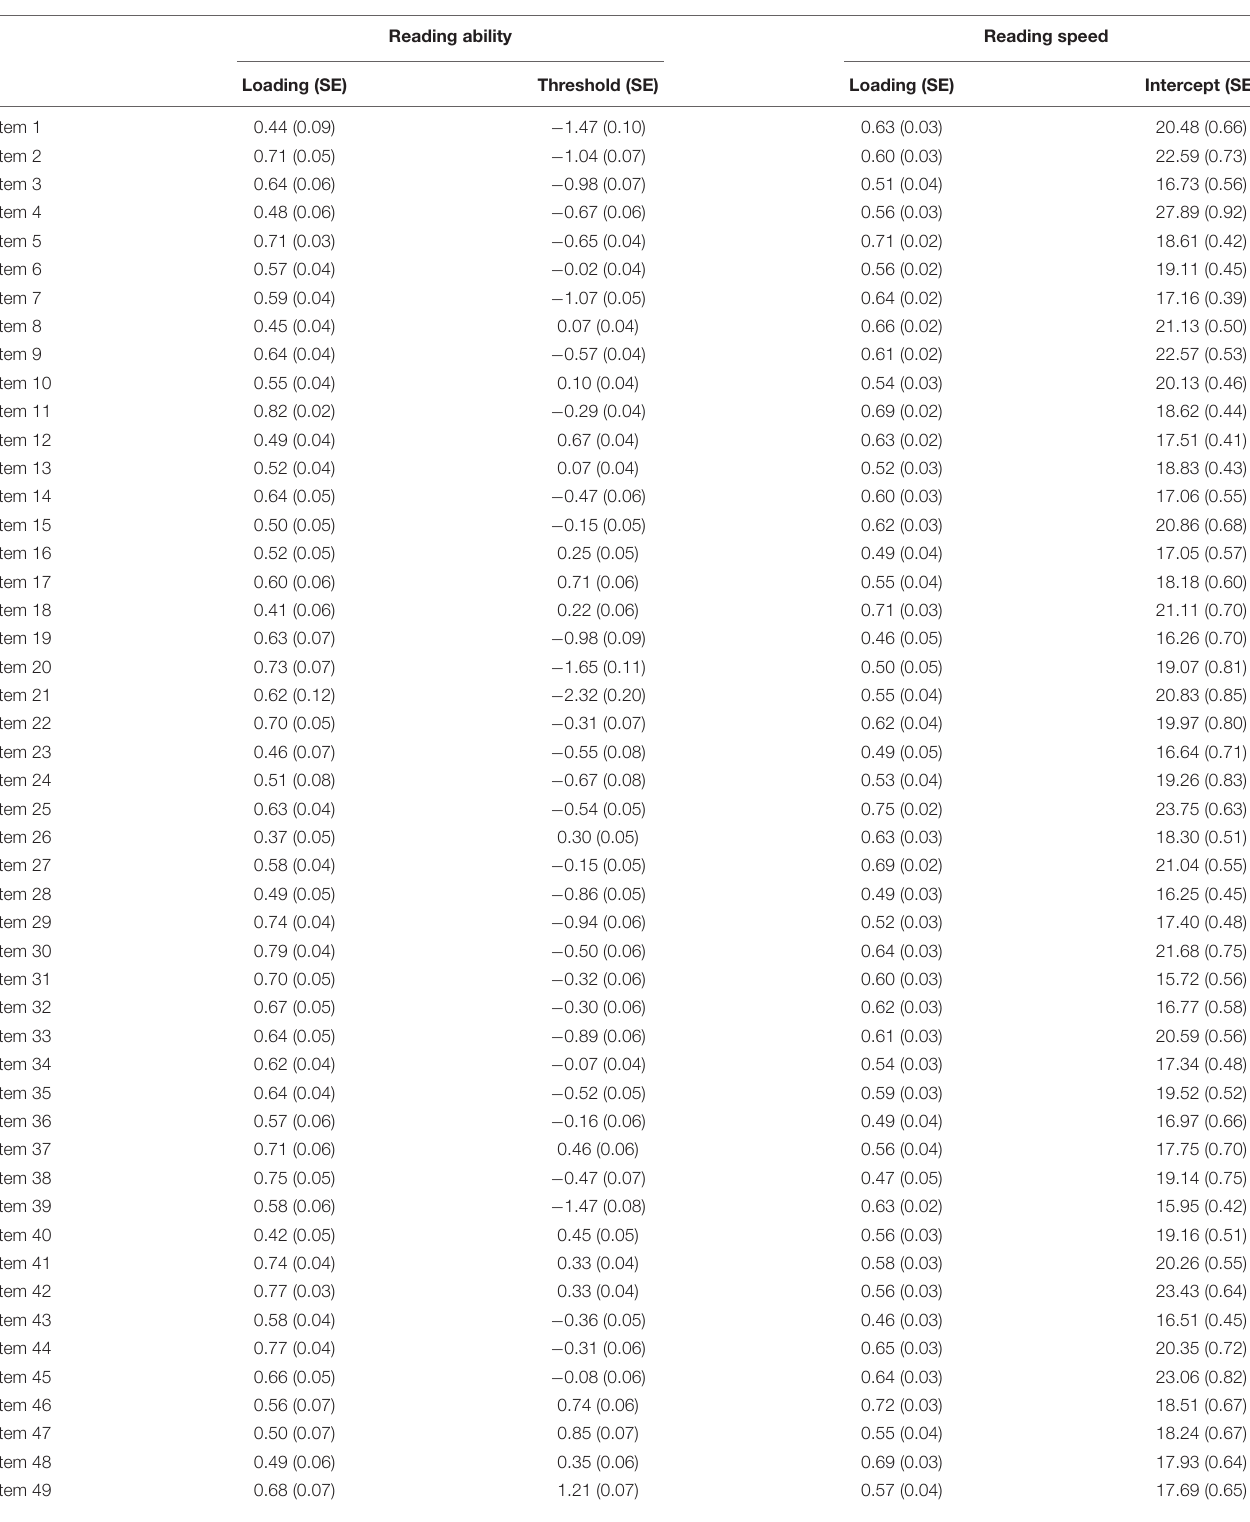
TABLE A1 | Measurement models reading (standardized